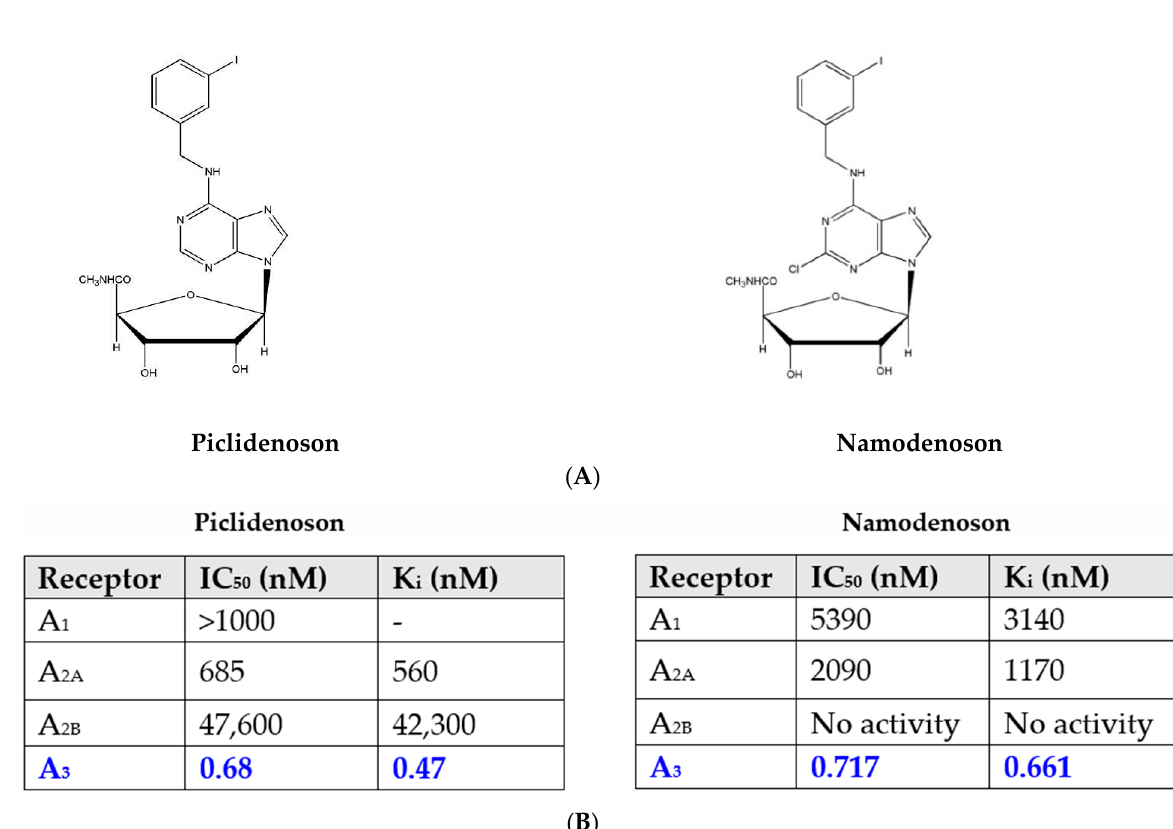
Figure 1. ( A ) Chemical structure of piclidenoson and namodenoson. ( B ) Affinity values of piclidenoson and namodenoson to the different adenosine receptors.